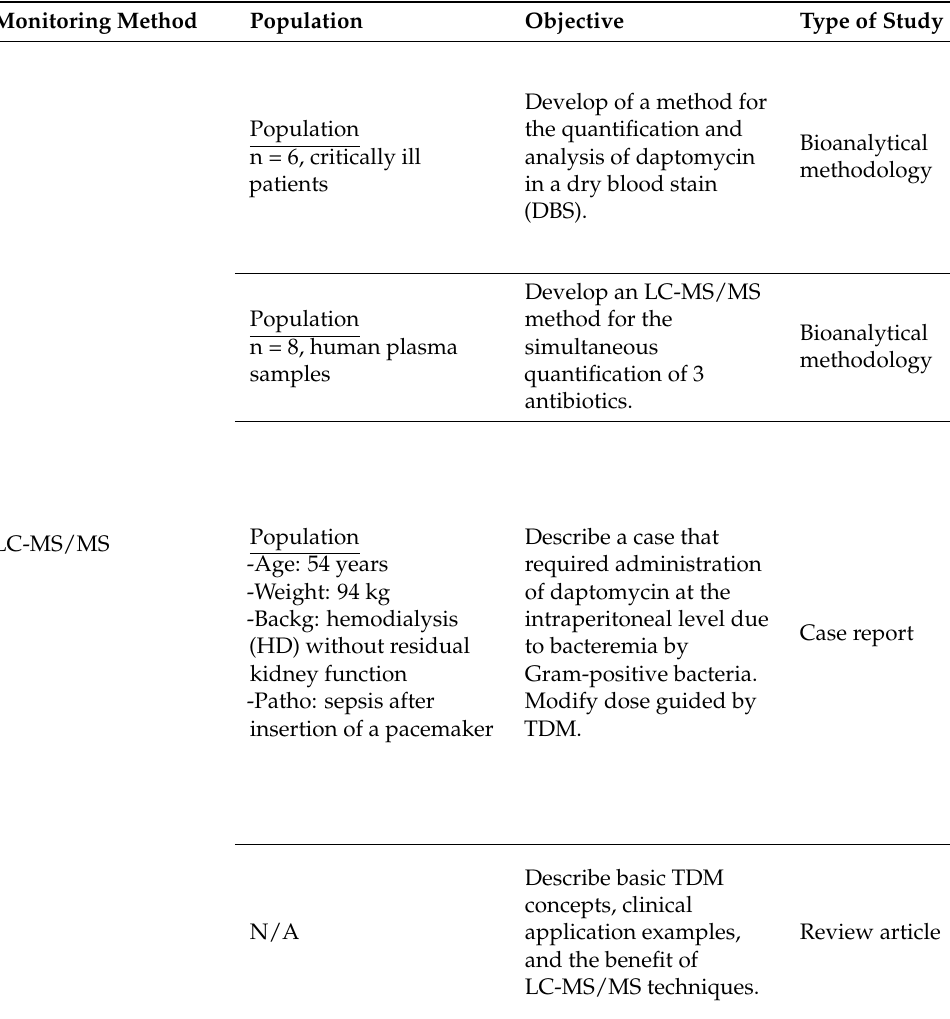
Table 1. Description of selected